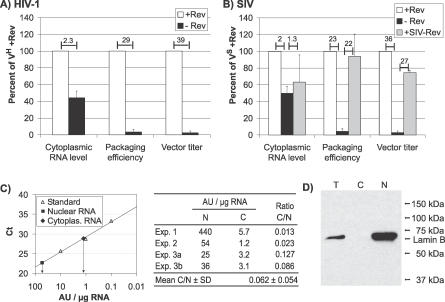
Effect of Rev on Encapsidation of HIV-1 and SIV Vector RNA(A) The HIV-1 vector plasmid VH was cotransfected with expression plasmids for HIV-1 gag-pol, VSV-G, and HIV-1 tat in the presence (+Rev) or absence (−Rev) of an HIV-1 rev expression plasmid. Cytoplasmic RNA levels, packaging efficiency, and vector titers are presented relative to the values obtained in the same transfection experiment with VH in the presence of Rev. The mean value and standard deviation of three to eight independent transfection experiments are shown.(B) The SIV vector plasmid VS was cotransfected with expression plasmids for SIV gag-pol, VSV-G, and HIV-1 tat in the absence (−Rev) or presence of an SIV (+SIV-Rev) or HIV-1 rev (+Rev) expression plasmid. The mean value and standard deviation of four independent transfection experiments are shown. Numbers above the bars indicate fold induction by Rev.(C) Using a real-time PCR for preGAPDH RNA, threshold cycle numbers (Ct) were determined for four nuclear (N) and cytoplasmic (C) RNA preparations in three independent experiments. Relative amounts of preGAPDH RNA levels were calculated as arbitrary units (AU) per microgram extracted RNA by including 10-fold serial dilutions of standard nuclear RNA preparations. Ct values of a typical experiment are shown in the left panel, and the table summarizes the results.(D) Western blot analysis of total cell lysate (T), and cytoplasmic (C) and nuclear (N) fractions for Lamin B.